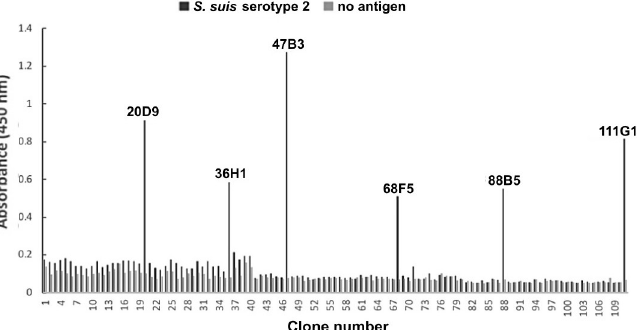
Fig 2. Identification of monoclonal phages specific to S . suis serotype 2 after whole cell-biopanning using a monoclonal phage ELISA.